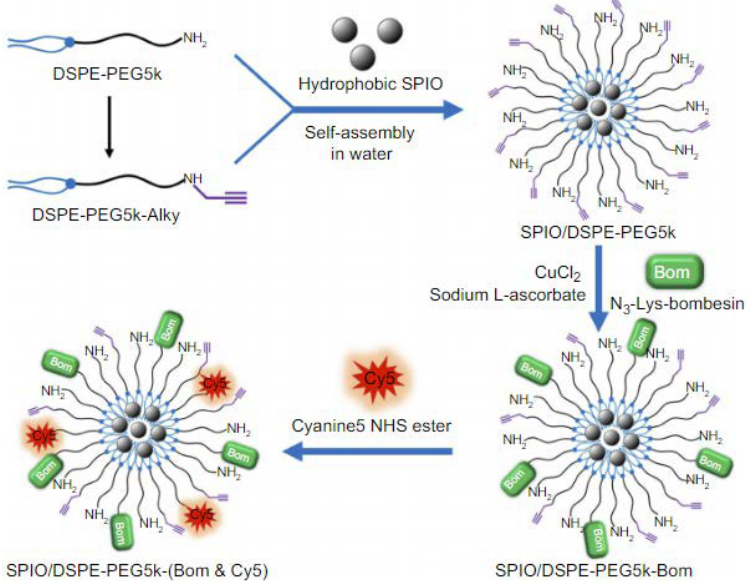
Figure 15. The steps of the synthesis of PEGylated, superparamagnetic iron oxide (SPIO) nanopar- ticles coupled with Lys3-BBN and Cy5 fluorophore. Adapted from ref. [60].